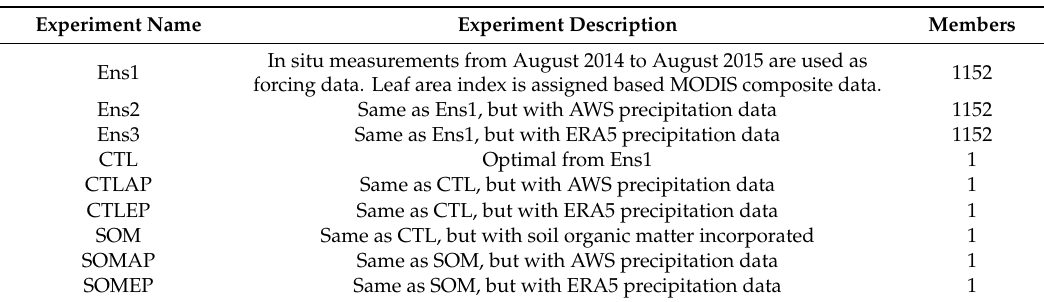
Table 4. Summary of